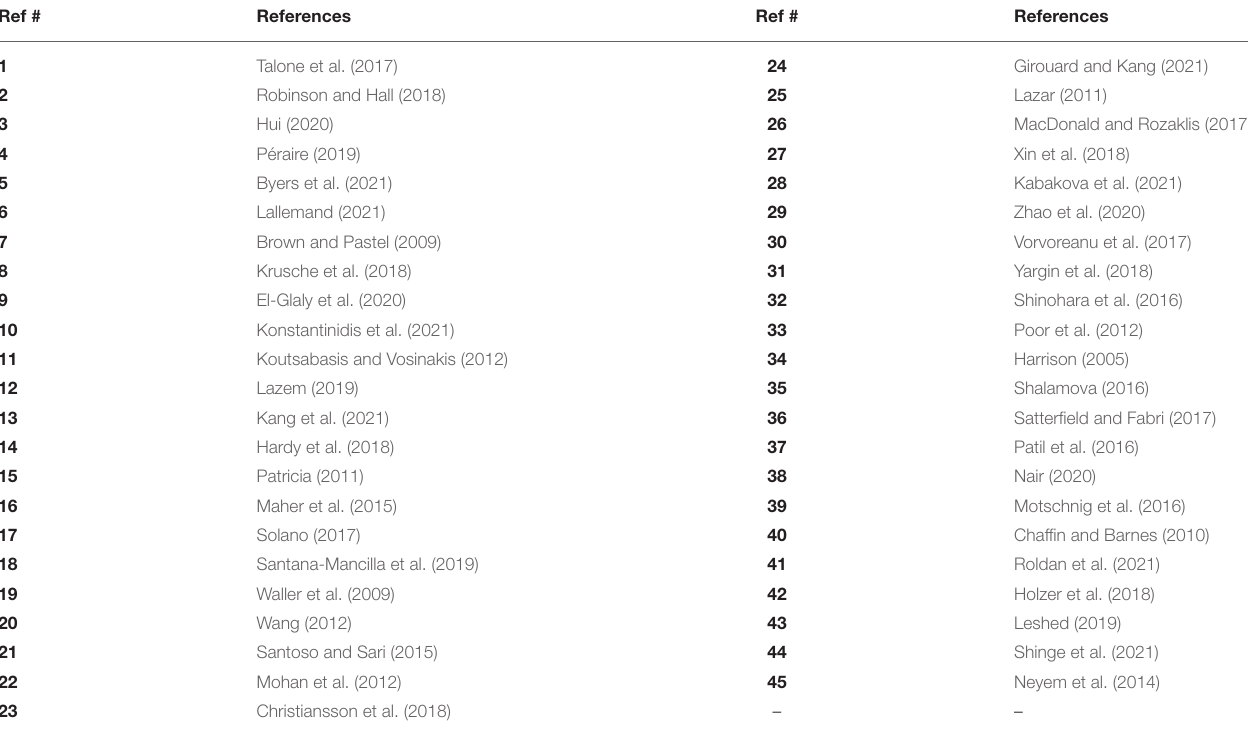
TABLE 3 | The authors of all articles in the review and their corresponding reference